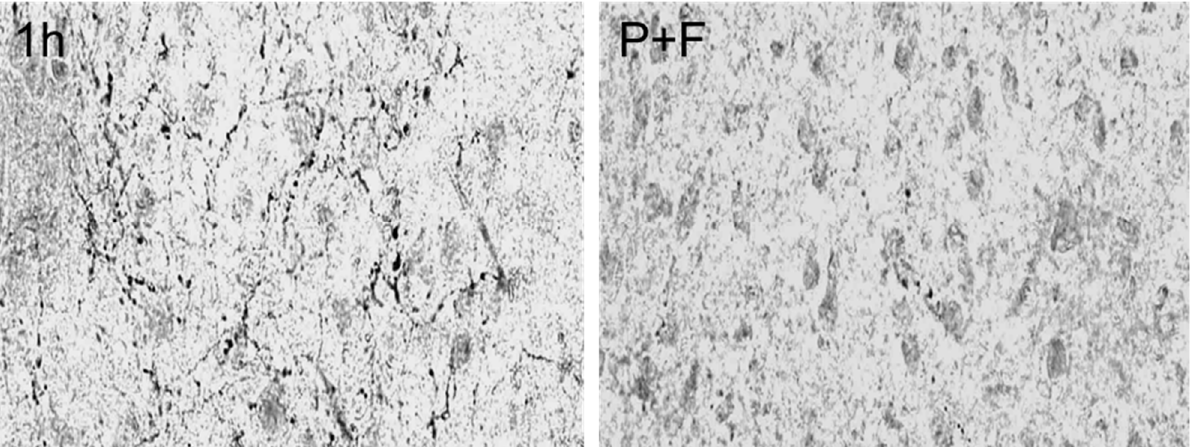
Figure A6. Substance P immunoreactivity in the suprachiasmatic nucleus of Syrian hamsters. Comparison between 1 h manual sleep deprivation (1 h, group 3a) and sexual stimulation with pheromone and females (P+F, group 1). Magnification: 200 ×